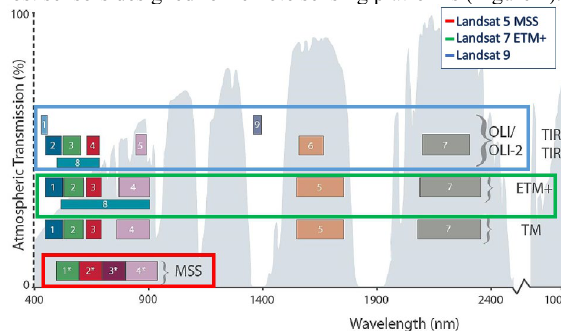
Figure 1. Landsat 5 MSS, Landsat 7 ETM+ and Landsat 9 sensors avoid absorption bands ~1400nm and 1900nm. Modified from Wulder et al.